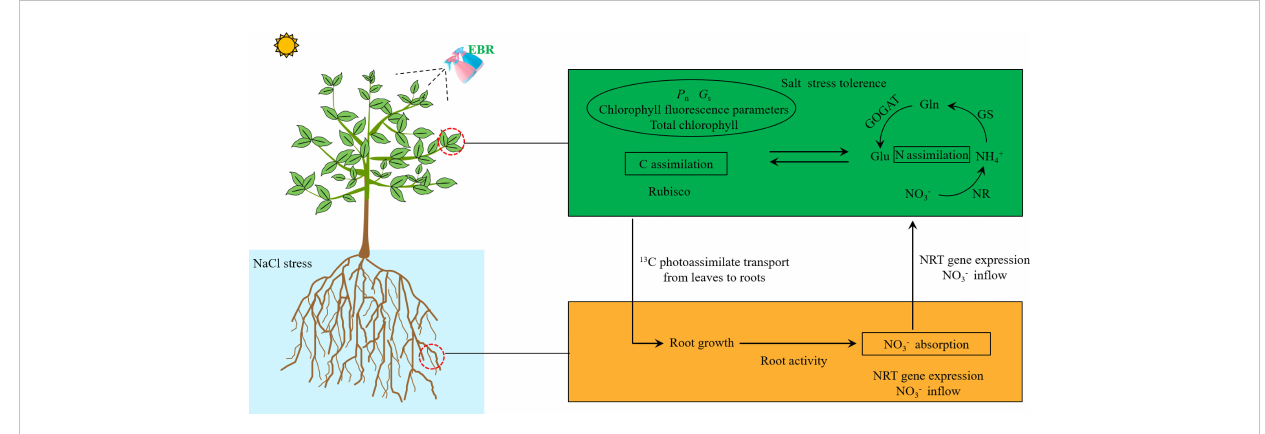
FIGURE 8 Schematic model displaying the role of EBR on nitrate nitrogen absorption and assimilation ef fi ciency in salt-stressed apple